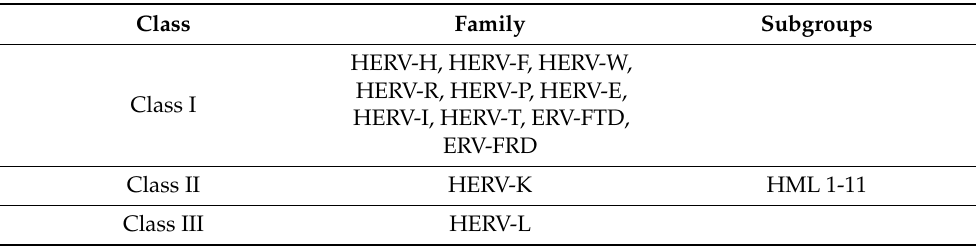
Table 1. Classification of human endogenous retroviruses (HERVs). HERVs are grouped into three classes, based on similarity to the exogenous Gammaretrovirus, Betaretrovirus and Spumavirus,